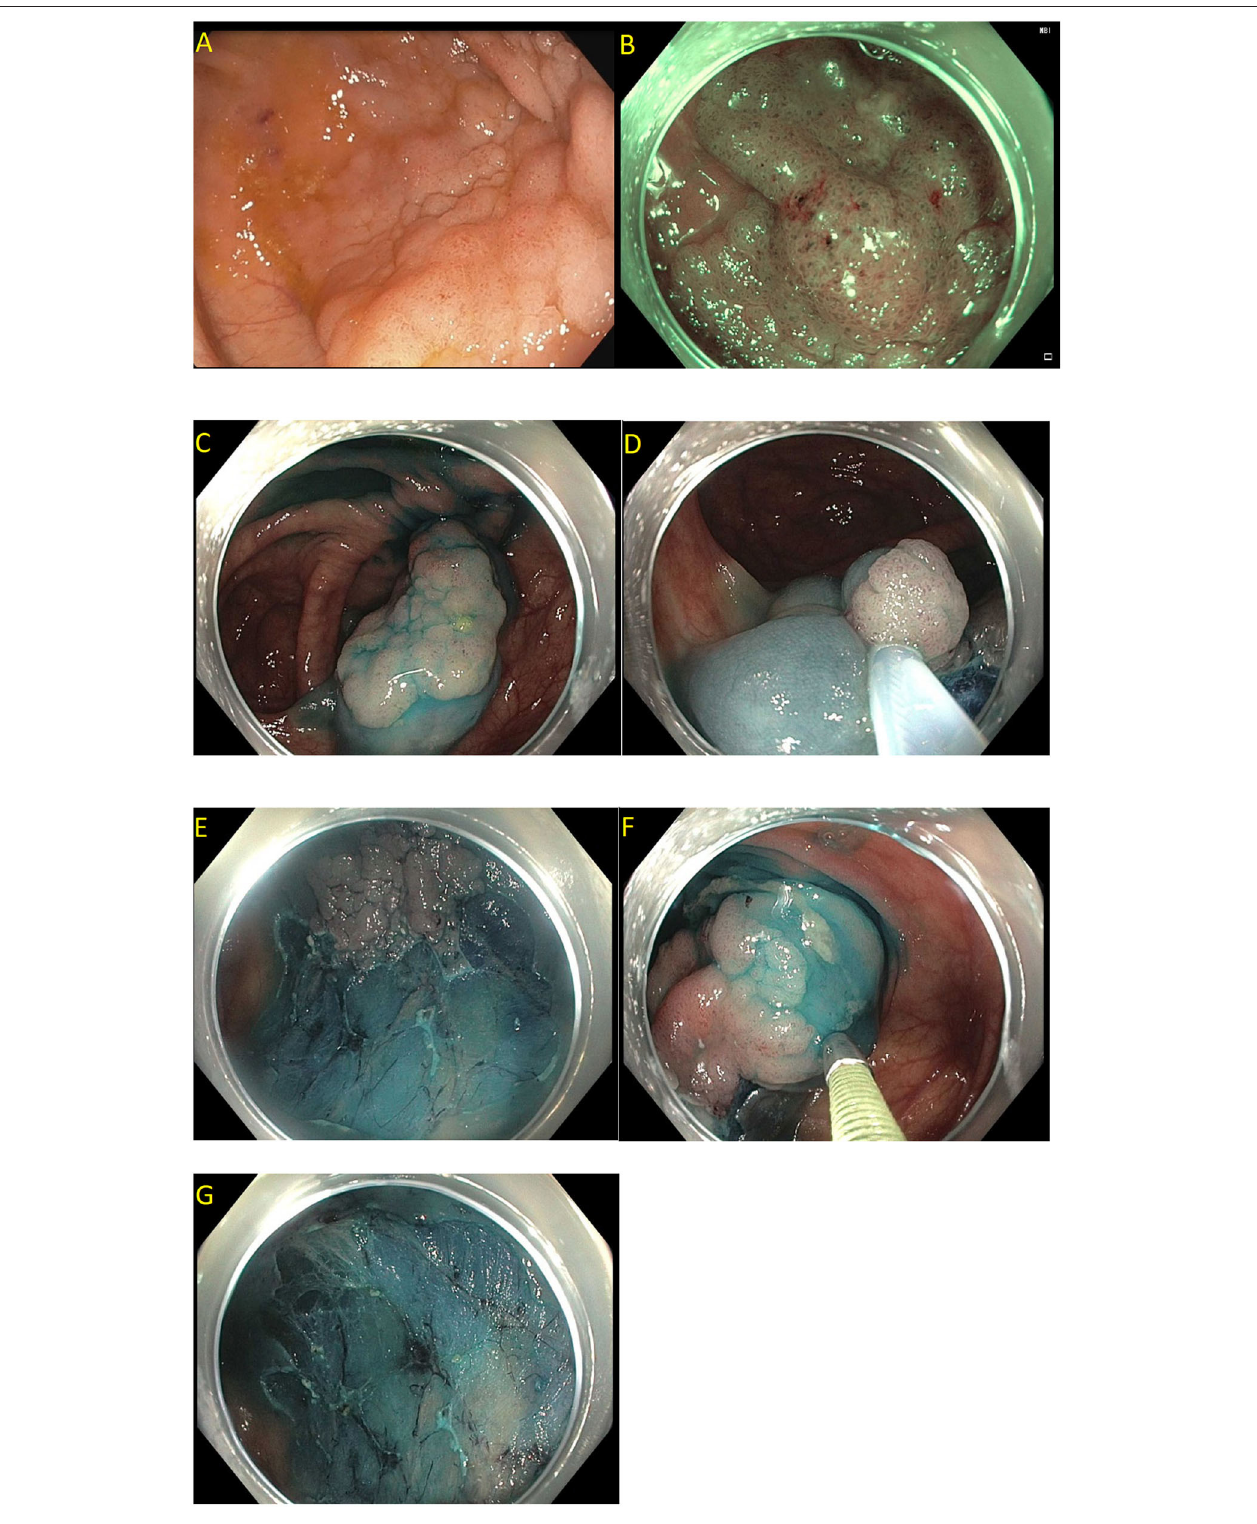
FIGURE 9 | Piecemeal endoscopic mucosal resection. (A) A 40mm Paris 0-IIa, granular lateral spreading lesion in the cecum seen on white light; (B) Same lesion seen under narrow band imaging; (C–G) Polyp removed by dynamic and piecemeal injection using a blended cutting current. The histology showed tubular adenoma.